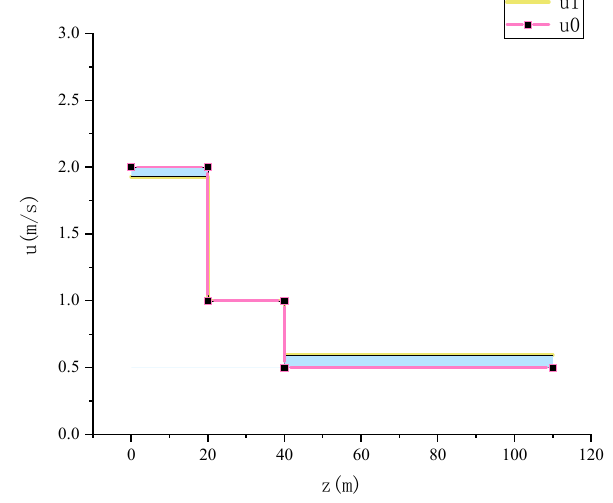
Figure 11. CNN to obtain the velocity compared with the real value.